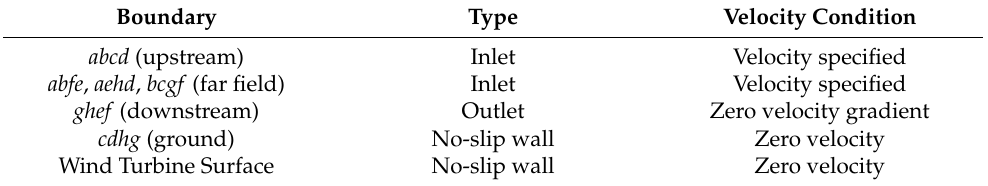
Table 3. Geometrical parameters of computational domain. Table 4. Boundary